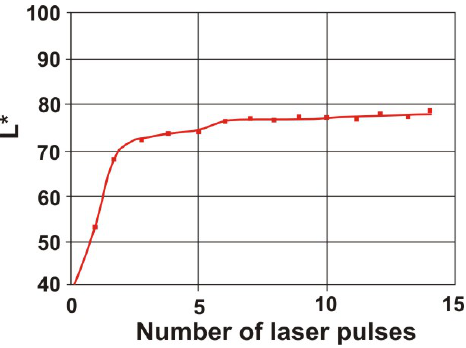
Figure 38. Dependence of the brightness L* on the number of laser shots (each 0.12 J/cm 2 ) in the laser cleaning of gypsum.